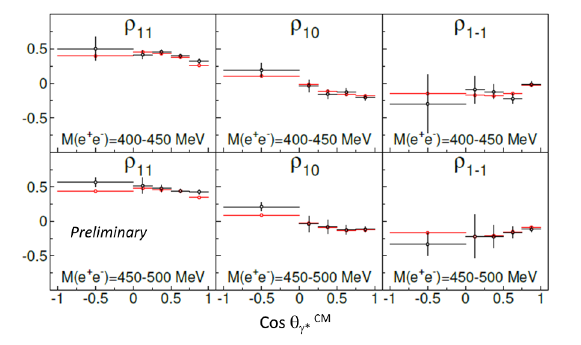
Figure 9. Expected precision on the spin density matrix ele- ments ρ 11 , ρ 10 , ρ 1 − 1 for 10 4 events as a function of z = cos θ CM and for two bins in dilepton invariant mass M ee . The red points show results obtained in the full solid angle and the black points Figure 8. The exclusive π − p → n e + e − reaction is selected using correspond to events measured within the HADES missing mass. The distribution of the lepton angle θ el in the γ ∗ reference frame is shown for γ ∗ angles in the center-of-mass in the bin 0 < cos ( θ CM ) < 0.5. The red curve represents the result γ ∗ of the fit weighted by acceptance and e ffi ciency [27].